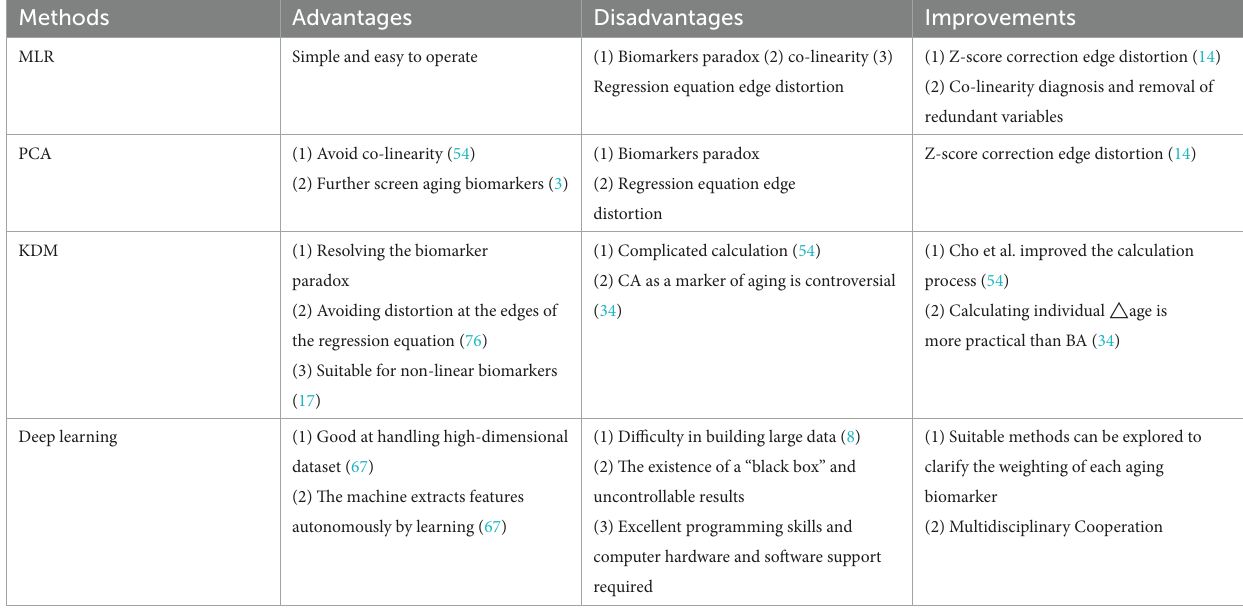
TABLE 4 The advantages and disadvantages of the four methods and possible effective